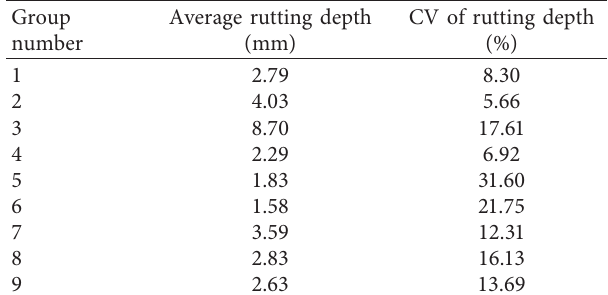
Table 6: The average rutting depth and CV values of each group under different test